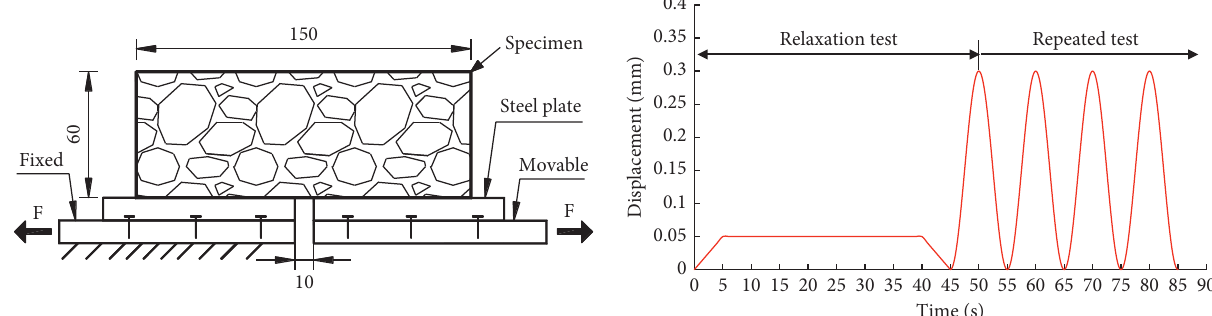
Figure 1: Test schematic diagram (unit: mm) and test loading model diagram in OT.